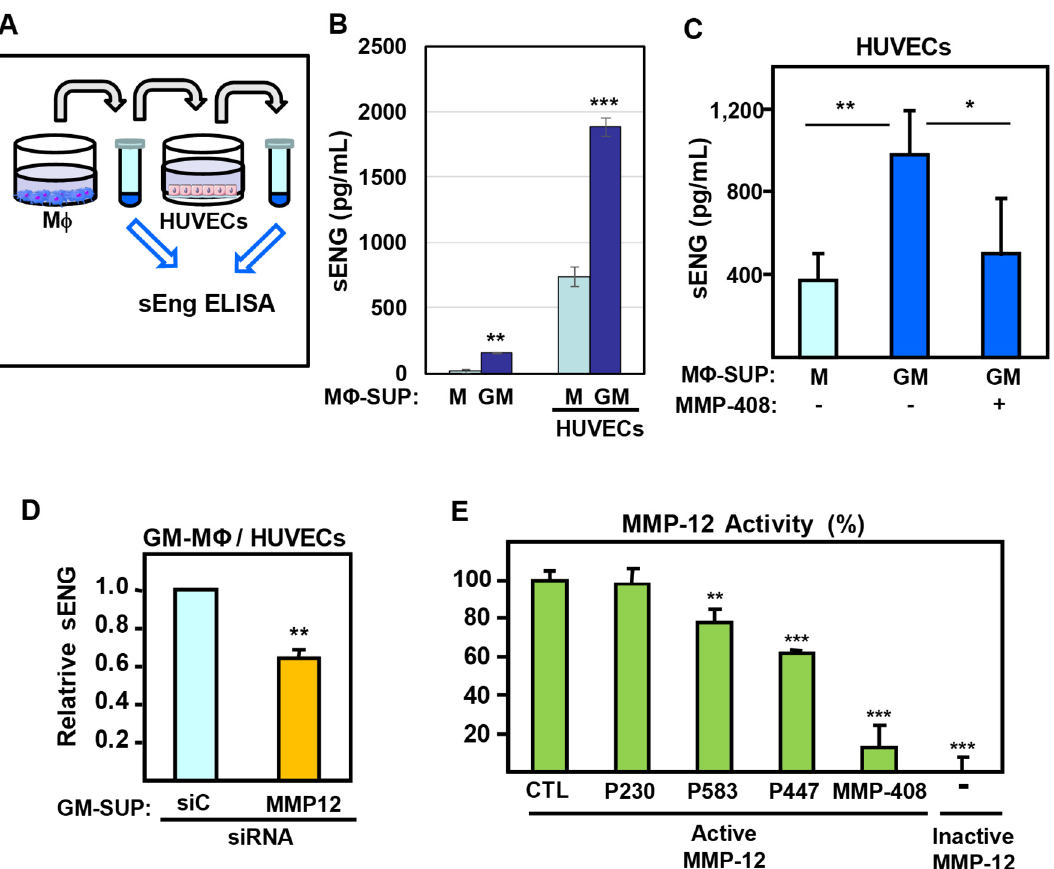
Figure 6. Secretion of endothelial soluble endoglin induced by M Φ supernatants. ( A – D ) As indicated in the scheme ( A ), culture supernatants (SUP) from GM-M Φ (GM) or M-M Φ (M) were added to monolayers of HUVECs. After 24 h incubation, the culture media were collected, and the sEng content was measured by ELISA in all samples. The values of sEng were calculated after subtracting the basal release of sEng present in HUVECs supernatants ( B – D ). ( B ) The levels of sEng from GM-M Φ and M-M Φ supernatants (left two bars) are compared to those after incubation with HUVECs (right two bars). ( C ) Soluble endoglin levels from GM-M Φ and M-M Φ supernatants after incubation with HUVECs in the presence or absence of MMP-408. ( D ) Soluble endoglin levels from supernatants of GM-M Φ , previously transfected with siRNA-MMP-12 or -control (siC), after incubation with HUVECs. ( E ) E ff ect of endoglin peptides (P230, P583, P447) and the specific inhibitor MMP-408 on the proteolytic activity of recombinant human MMP-12. Control samples with vehicle (CTL), the GL-less peptide P230, as well as an inactive MMP-12, are included. The MMP-12 activity was measured using the fluorogenic substrate Mca-PLGL-Dpa-ARNH2, and the statistical significance respect to the control sample (CTL) is indicated. Statistical analysis ( n = 3) was calculated using the ANOVA test, and data are presented as mean ± SD. (* p < 0.05; ** p < 0.01; *** p <